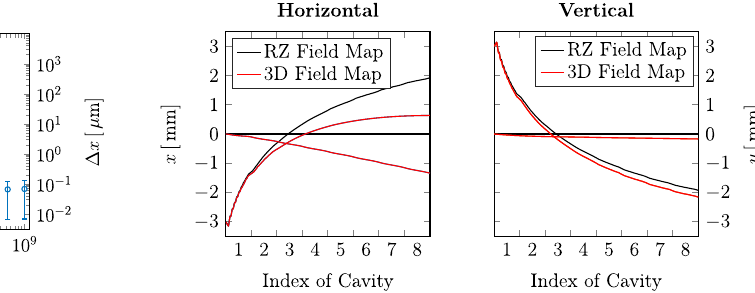
FIG. 2. Comparison between ASTRA tracking and beam transport calculated with analytically (left) and numerically (right) derived transfer matrices. The difference of horizontal offset Δ x in respect to an ASTRA reference is plotted as a function of initial beam energy. The range between the dashed lines indicates the range of the typical beam energy in the injector module at both, FLASH and E-XFEL.